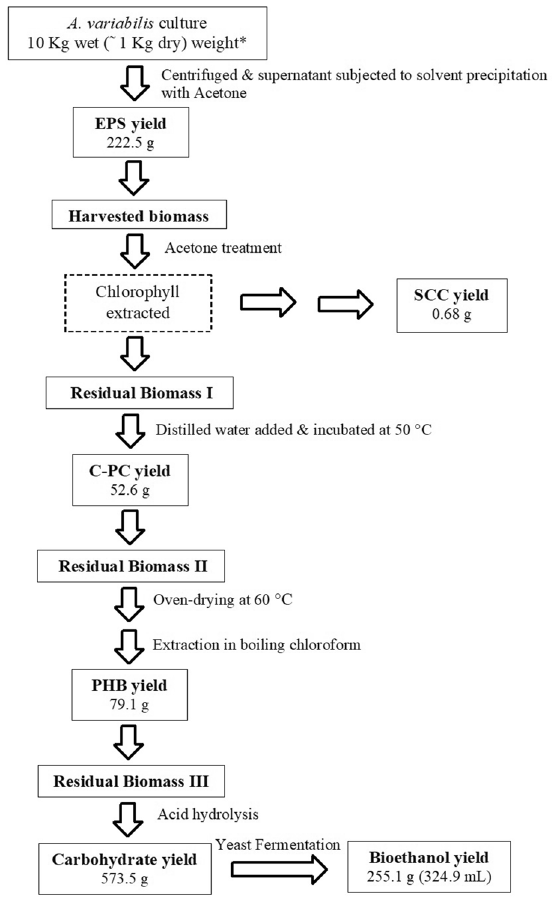
Figure 5. Detailed process of sequential extraction of different products from A. variabilis under cyanobacterial refinery approach. *1 kg dry biomass corresponds to ≈1176 L culture